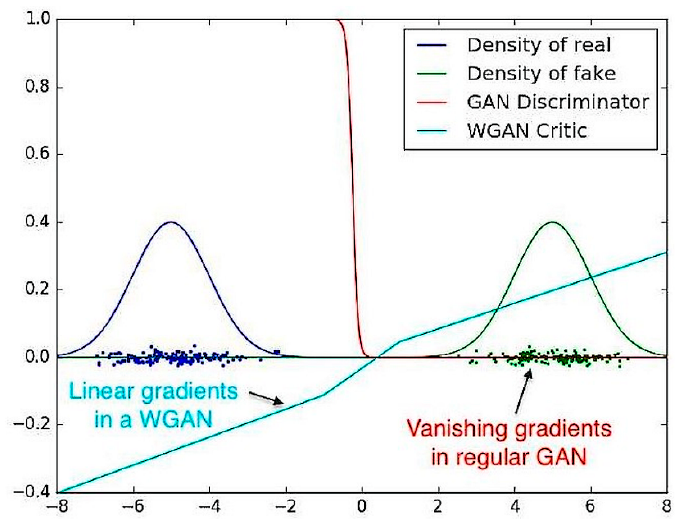
Figure 12. Behavior of gradients of GAN discriminator and WGAN critic.